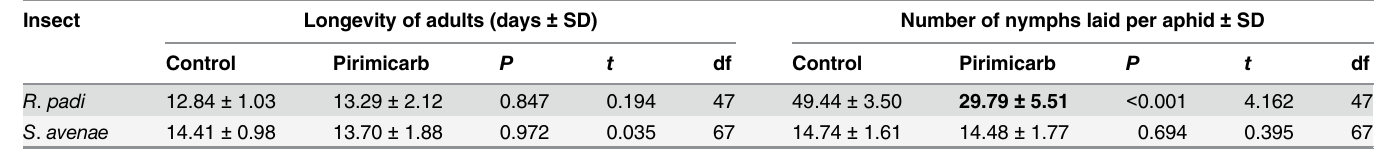
Table 2. Effect of LC 25 of pirimicarb on longevity and fecundity of R . padi and S . avenae from the parent generation.